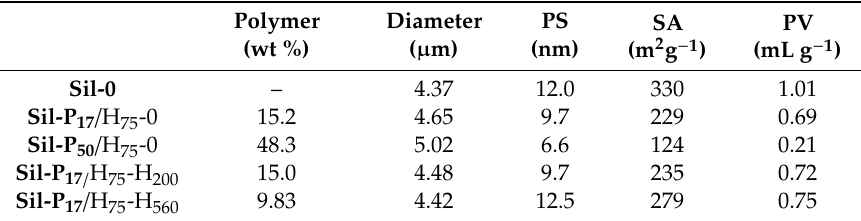
Table 3. Particle characterization after the polymer lamination and heat treatment.